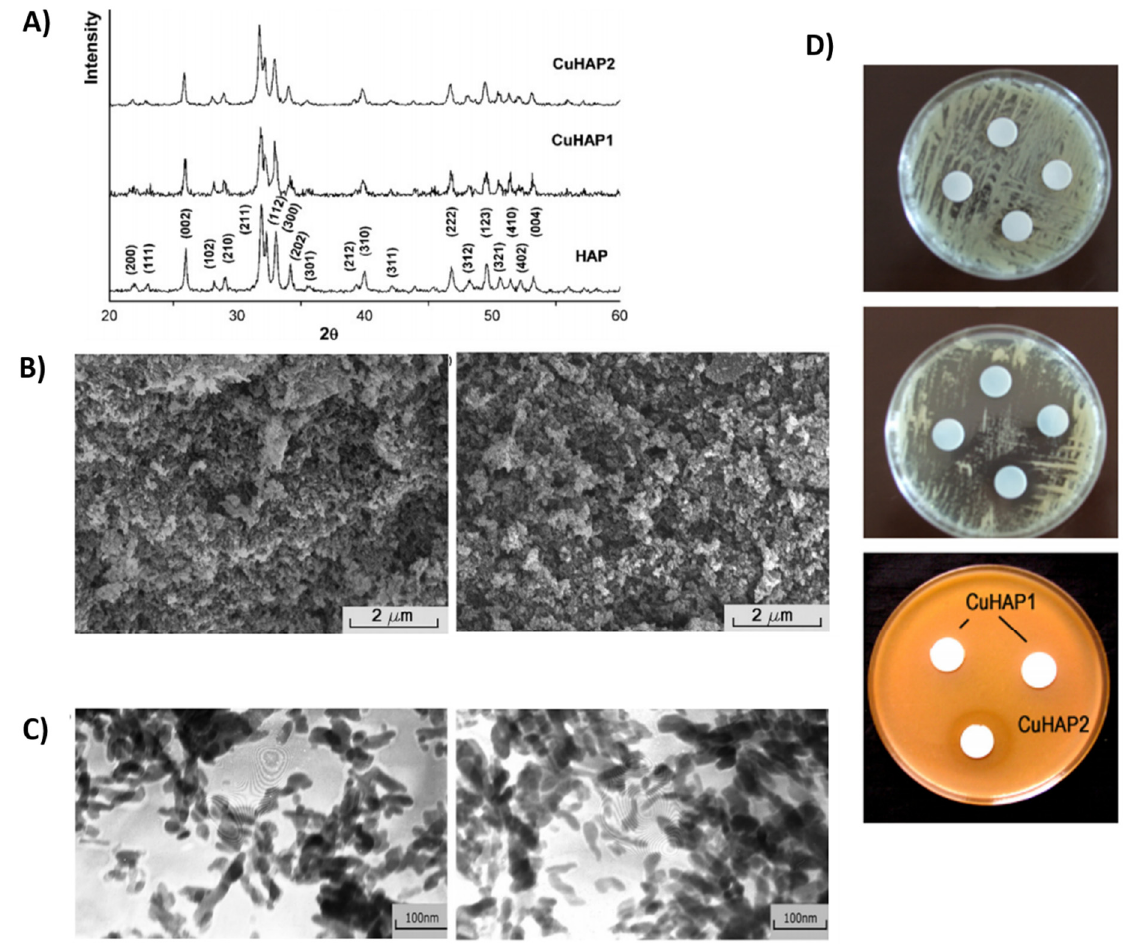
Figure 16. ( A ) shows the XRD patterns of the HAP- and Cu-doped samples. ( B ) shows scanning electron micrographs of CuHAP1 (left) and CuHAP2 (right). Bar equals 2 µm. ( C ) shows transmission electron micrographs of CuHAP1 (left) and CuHAP2 (right). ( D ) (upper and middle) shows photographs of antimicrobial test results of CuHAP1 and CuHAP2 samples against E. coli , respectively. ( D ) (lower) shows antimicrobial test results of CuHAP1 and CuHAP2 against C. Albicans. Scale bar equals 1 cm. Adapted from [201]. Reproduced with permission from Elsevier.